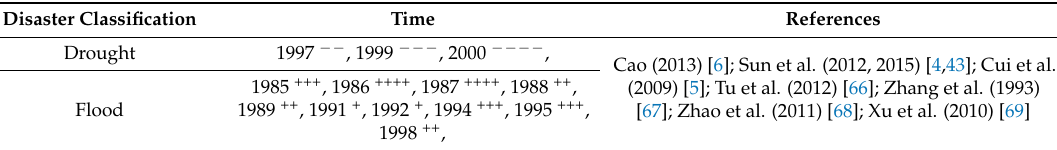
Table 6. Disaster situation in the study area obtained from previous studies.